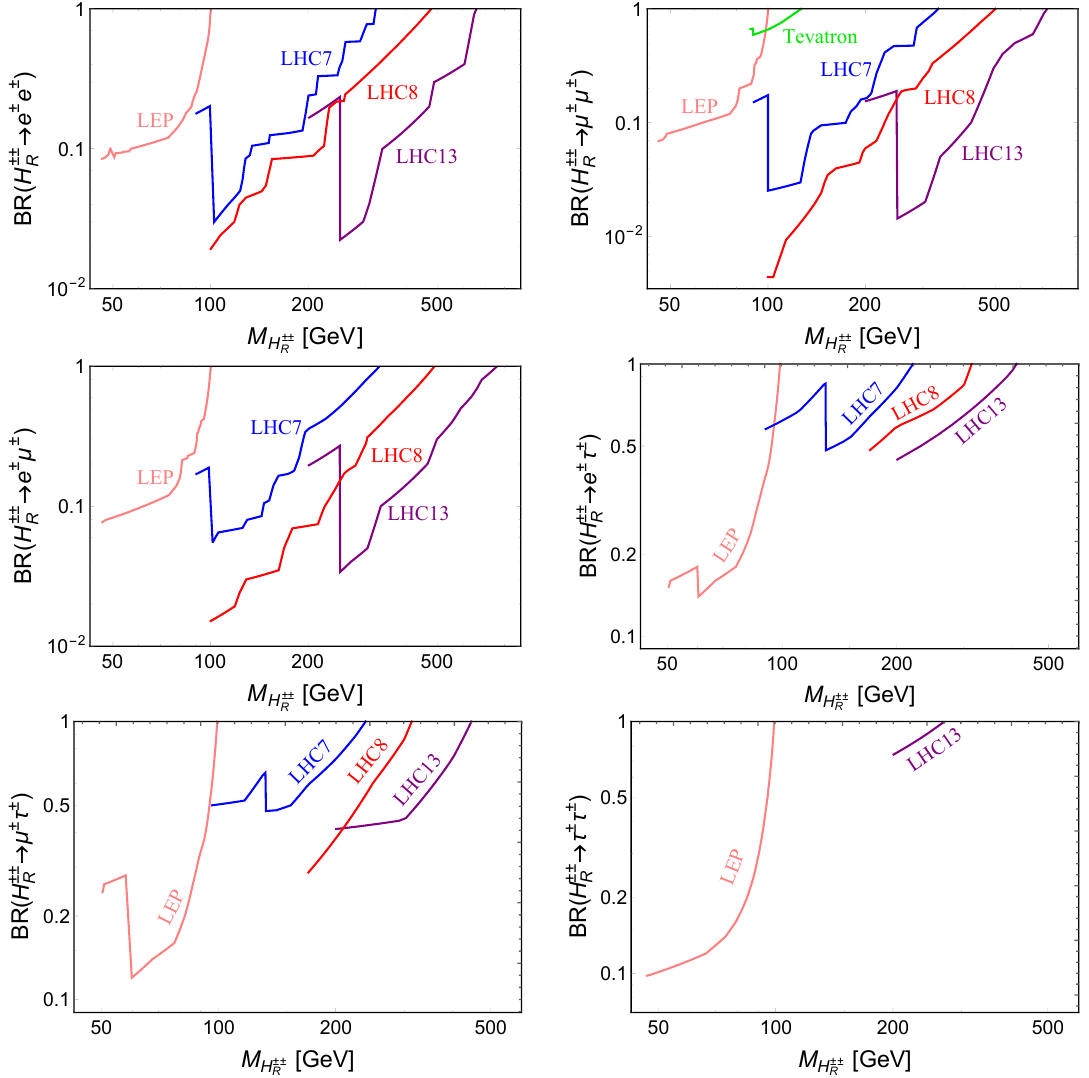
Figure 12 . 90% CL lower limits on M